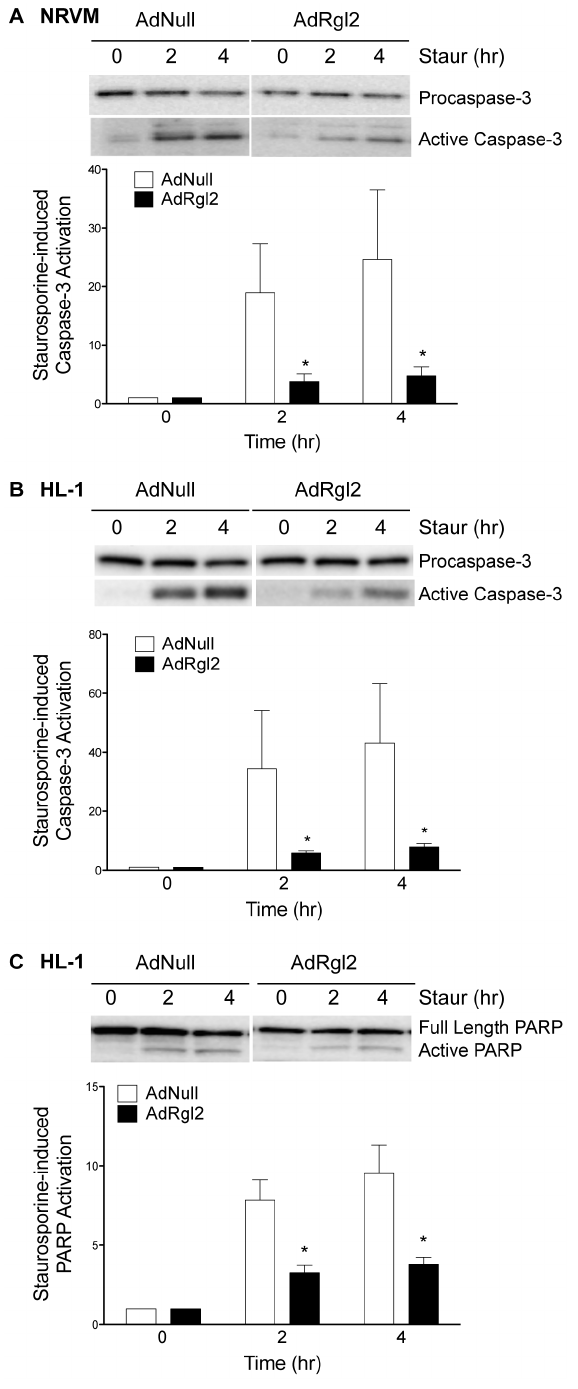
Figure 5. Effect of Rgl2 on apoptotic pathways in cardiomyo- cytes. AdNull- and AdRgl2-infected NRVMs ( A ) and HL-1s ( B and C ) were treated with staurosporine (Staur, 1 m M) for 0, 2, and 4 hr. Caspase-3 ( A and B ) and PARP ( C ) activation were determined by immunoblot of cell lysates using antibodies to activated caspase-3, procaspase-3, and PARP. Active (cleaved) caspase-3 and PARP densities were normalized to total enzyme and are expressed relative to the respective control value (0 hr Staur). Shown are representative immunoblots from a single experiment and the means 6 SEM of at least 3 separate experiments. * denotes significant difference compared to AdNull infected cells.